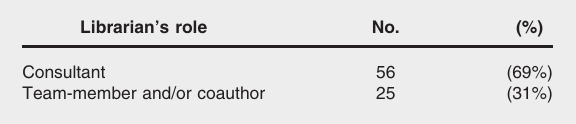
Survey results for librarian’s role (n ¼ 81)